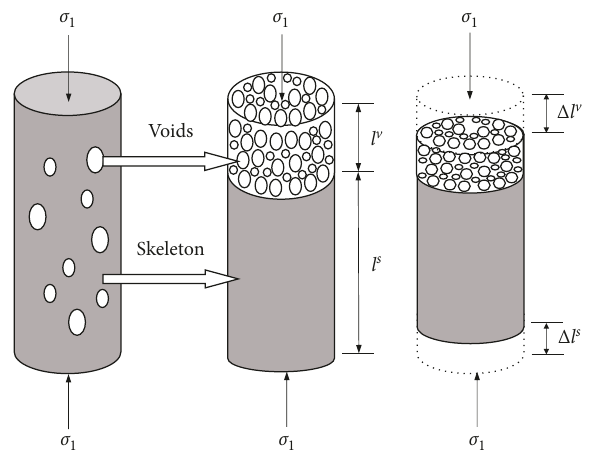
Figure 4: Schematic representation of the compression process in rock